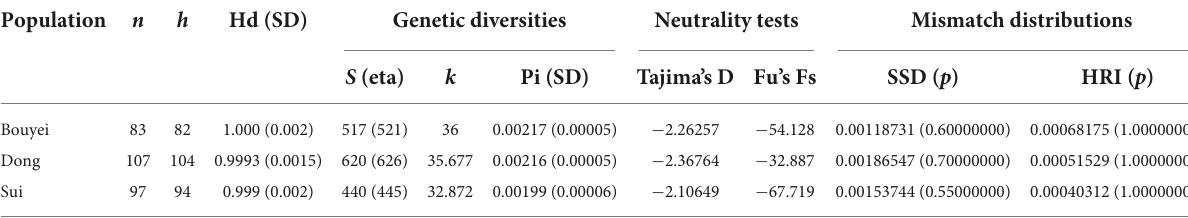
TABLE 1 Diversity indexes and neutrality tests for the studied Tai-Kadai-speaking populations based on the whole mitogenomes.